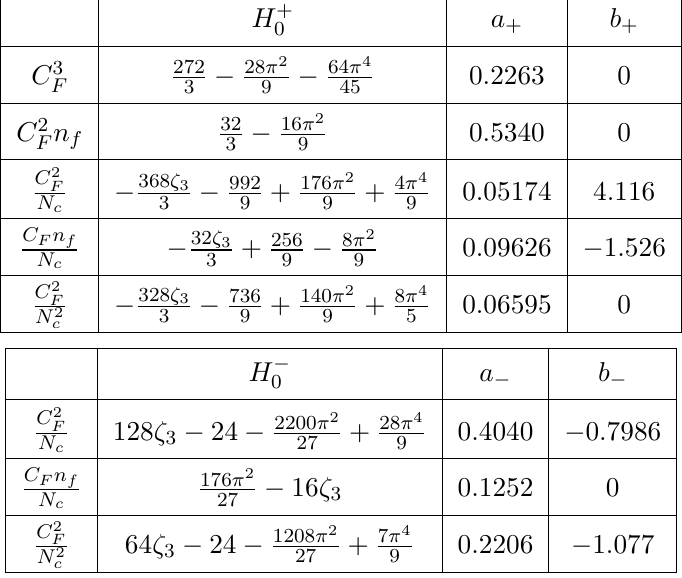
Table 2 . Values of the parameters in the ansatz for (cid:14)H (3 (cid:6) )